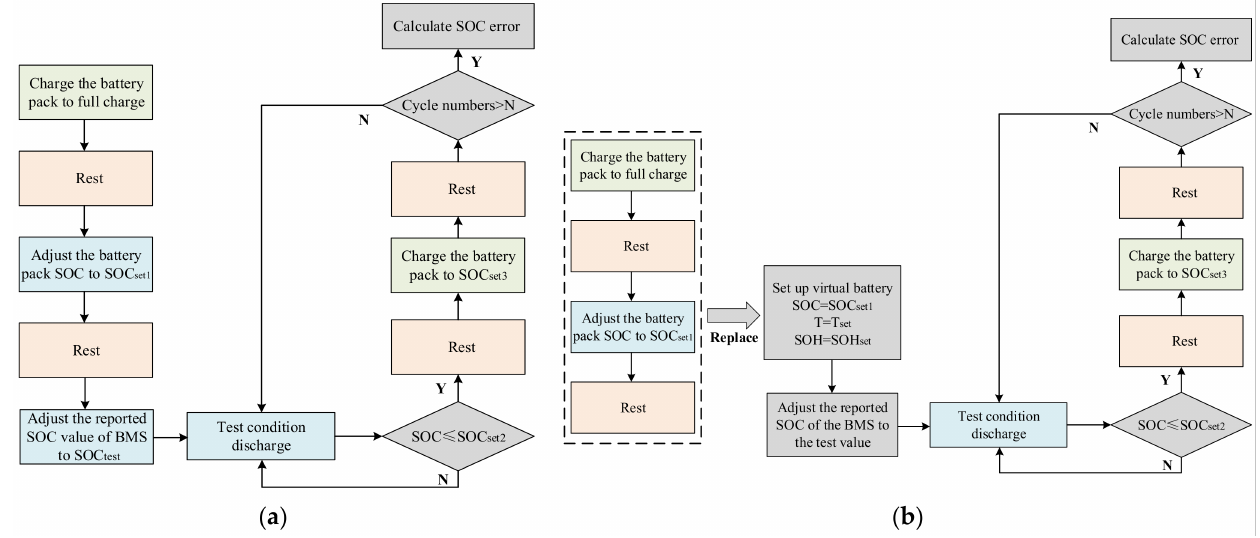
Figure 7. SOC error correction speed test flow: ( a ) based on actual battery pack; ( b ) based on virtual battery